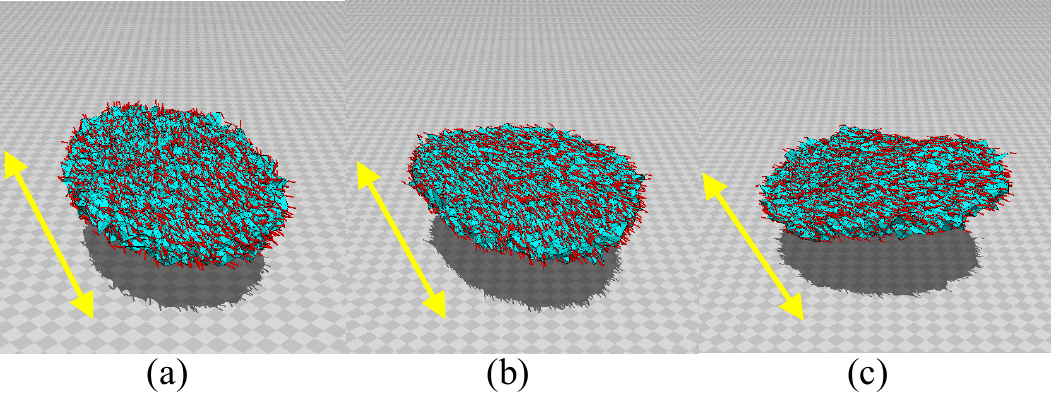
Figure 5. Snapshots of disks obtained in the simulations without light irradiation and under the conditions ( a ) λ = 1.2, ( b ) λ = 2.4, and ( c ) λ = 1.2 with κ = 0.5. The sizes are ( a ) D / H = 12, N = 10,566, ( b ) D / H = 16, N = 10,980, and ( c ) D / H = 20, N = 10,563. The arrows ( ↔ ) represent the nematic director